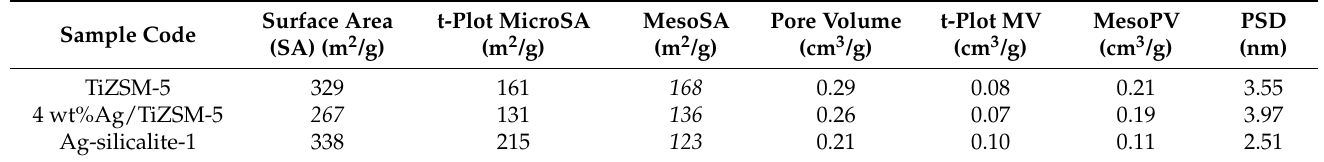
Figure 5. Representative sequence for FUR1 gene of C. auris with no variation. Table 3. Textural characteristics of ZSM-5 modified